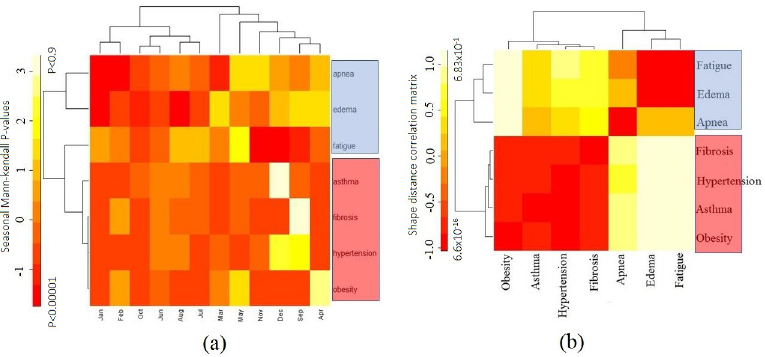
Fig 8. Widespread seasonal sensitive comorbid diseases. (a) Seasonal Mann-Kendall p-values of seasonal sensitive life style diseases represented as heat map for the entire period (Jan 2004 to Dec 2016). The hierarchical clustering clearly divided them into diseases with (red box) and without (blue box) season trend. (b) Shape based distance matrix scores among the major highly comorbid diseases of high altitude represented as heat map for the entire period (Jan 2004 to Dec 2016). The hierarchical clustering clearly divided them into diseases with (red box) and without (blue box) seasonal pattern matching. Please note that the four diseases (obesity, asthma, hypertension, and fibrosis) in the red boxes have similar seasonal trends and seasonal patterns named as “Group1” diseases ( S1 Table